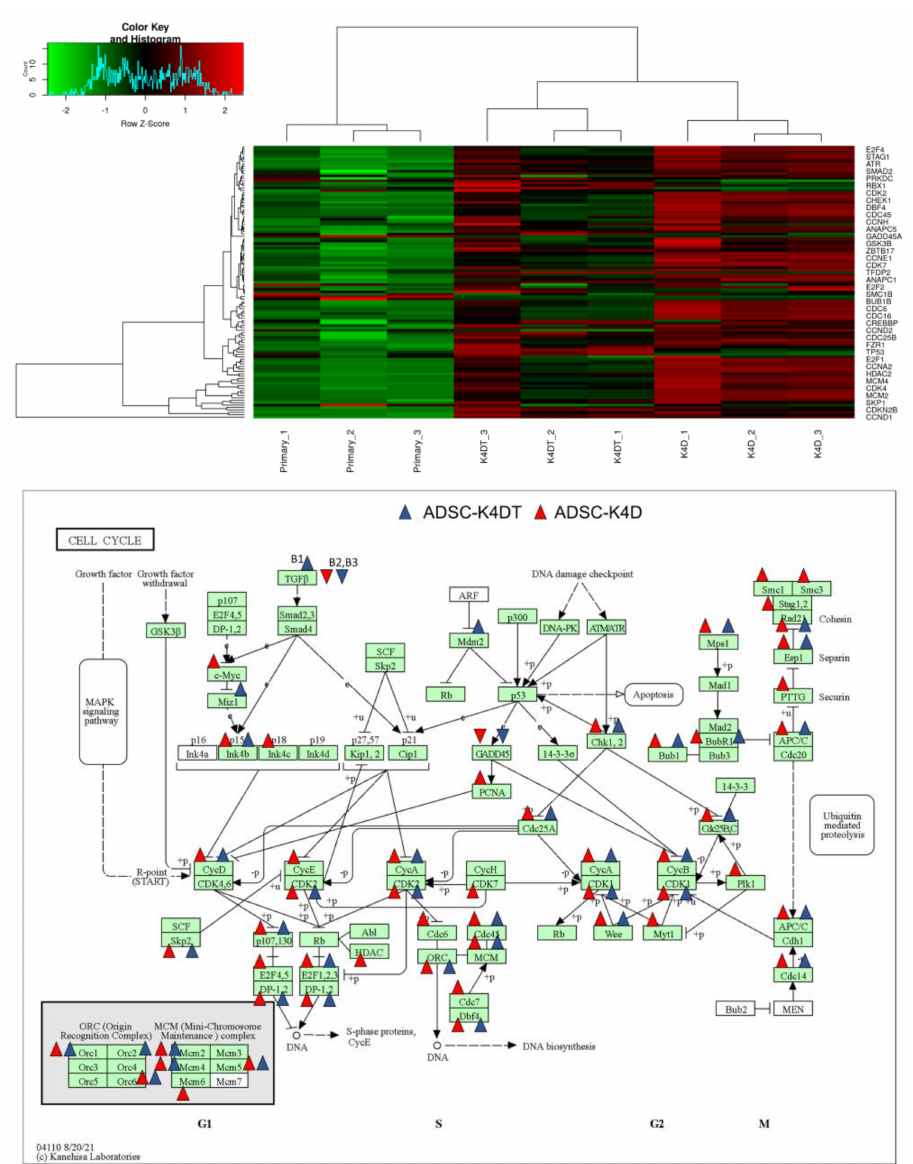
Figure 11. RNA-seq analysis of the cell cycle-related genes. Upper panel: Heatmap of the genes listed in the cell cycle pathways in the primary ADSCs, and the ADSC-K4DT and ADSC-K4D cells. Red indicates high expression, and green indicates low expression. Lower panel: Summary of the up- and down-regulated genes among the KEGG cell cycle-related genes. Arrowheads indicate the up- or down-regulated genes in the ADSC-K4DT and ADSC-K4D cells. The genes with an adjusted p -value of < 0.05 and fold change of >2 or <0.5 compared with the primary ADSCs were